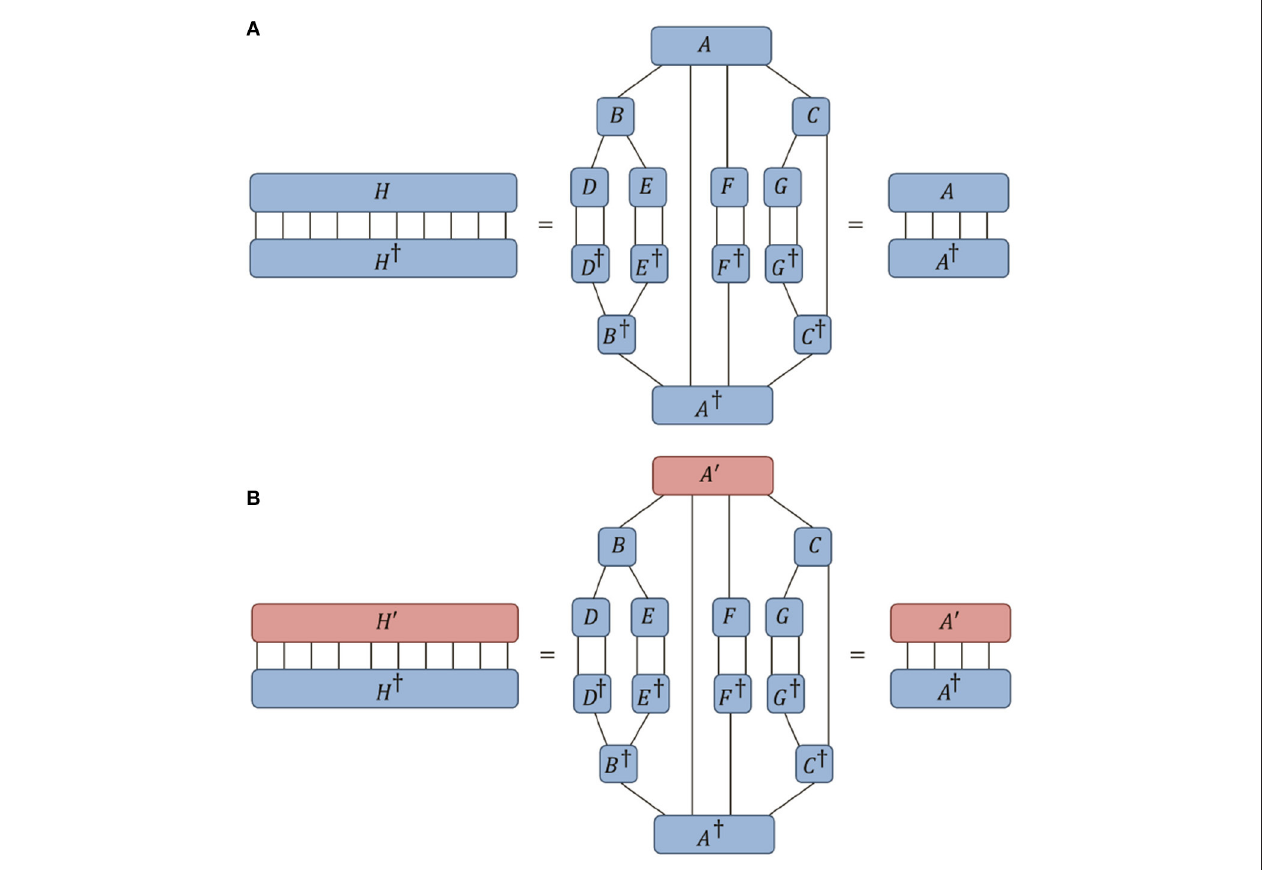
FIGURE 13 | (A) In the network from Figure 12A , if the tensor A is an orthogonality center then it follows that the norm of the network k H k is equal to the norm of the center tensor k A k . (B) Similarly it follows that, in changing only the center tensor A → A ′ , the global overlap between the networks H and H ′ is equal to the local overlap between the center tensors A and A ′